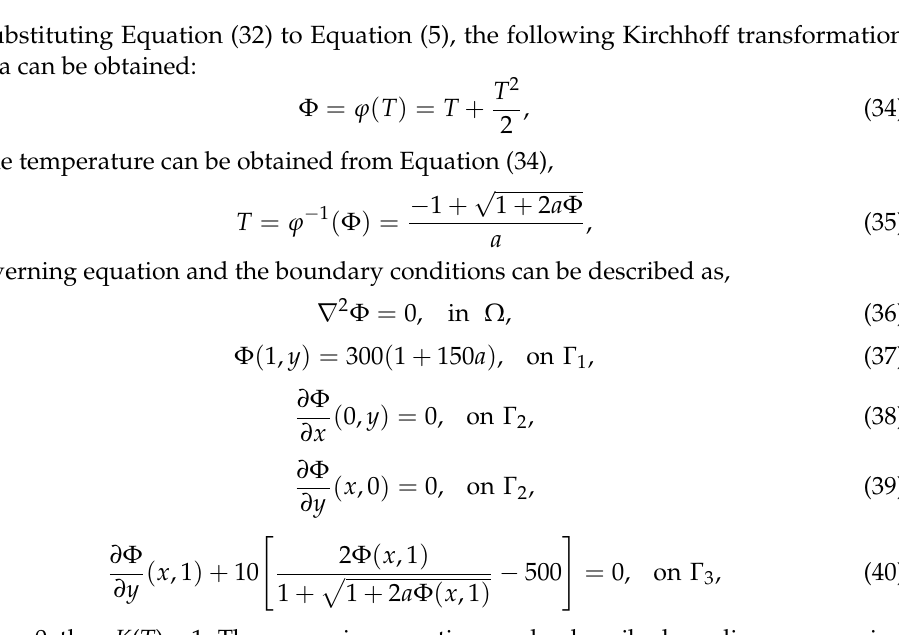
Figure 2. Schematic of the computational domain of case 1.